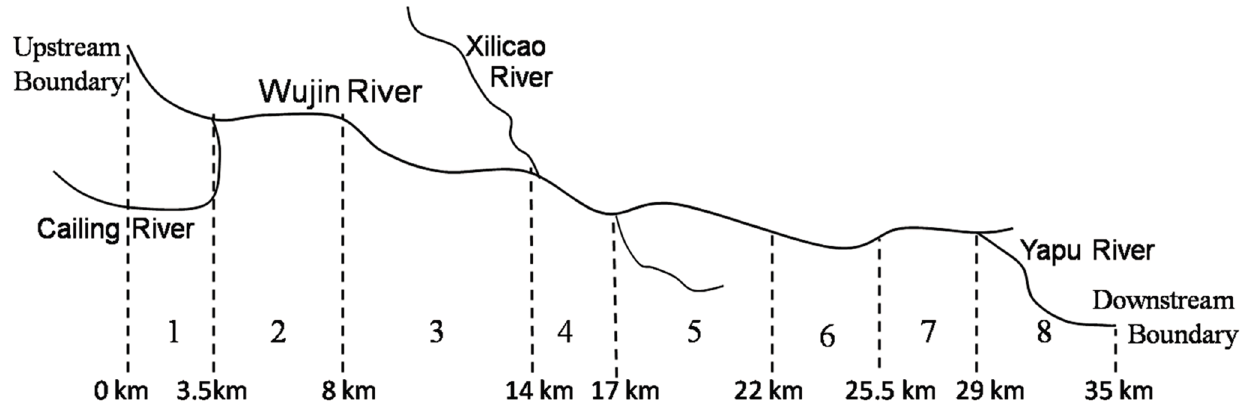
Figure 2. System segmentation and three tributaries of Wujin